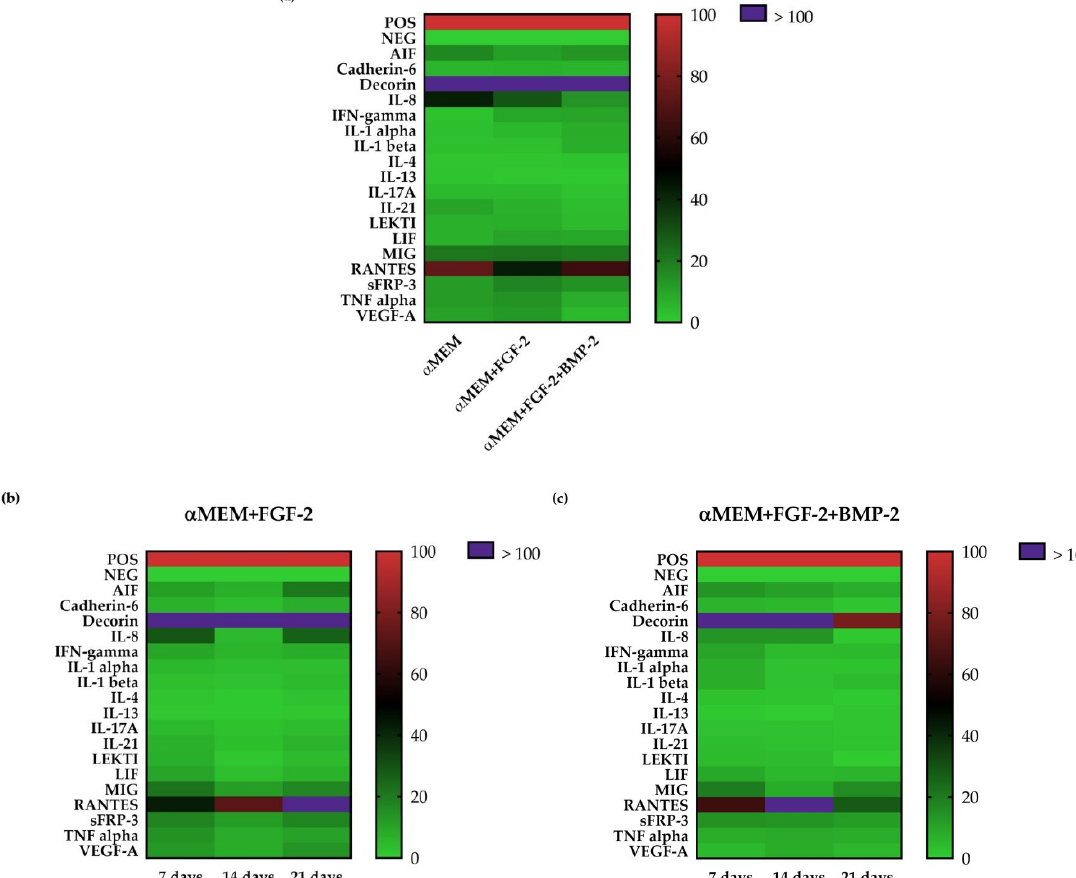
Figure 8. ( a ) Secretion profile of sheep BM-MSCs using the semi-quantitative C-Series Ovine (Sheep) Cytokine Array C1 Kit, depending on culture conditions. ( b ) Secretome of BM-MSCs treated with FGF-2 alone, or ( c ) FGF-2 and BMP-2 after 7, 14 and 21 days of incubation.